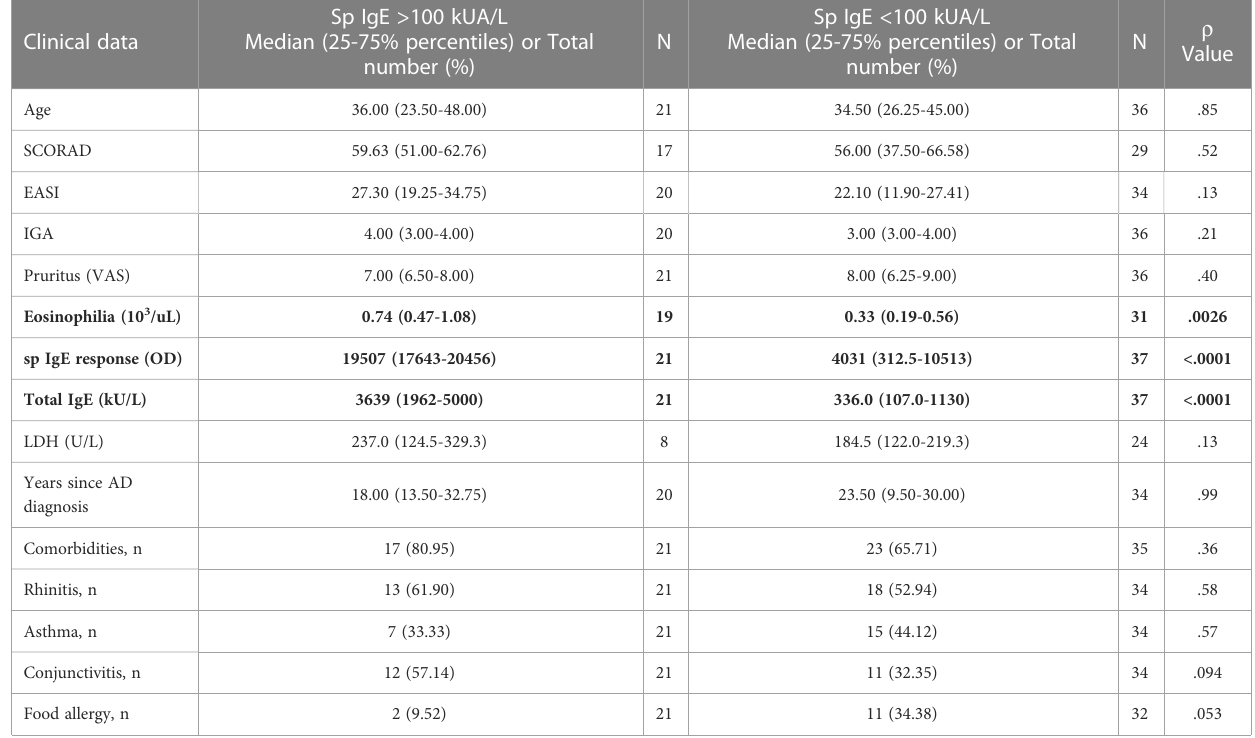
TABLE 2 Differences in clinical characteristics between patients with sp IgE >100 kUA/L and patients with sp IgE <100 kUA/L.